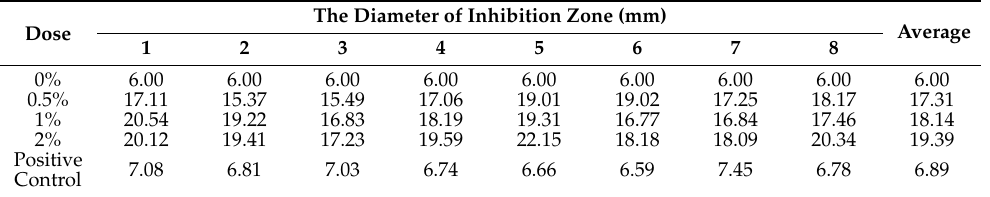
Table 2. Antibacterial activity of hand sanitizer gel towards Staphylococcus aureus bacteria.